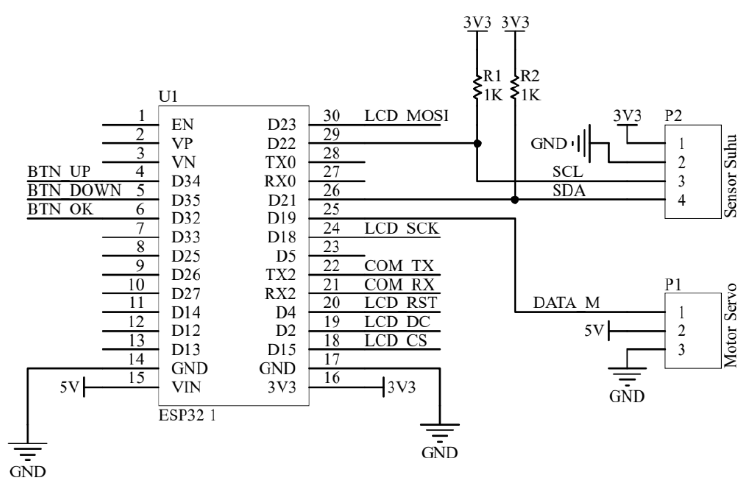
Figure 7. Circuit of temperature sensor connected with Figure 7. C ircuit of temperature sensor connected with microcontroller.